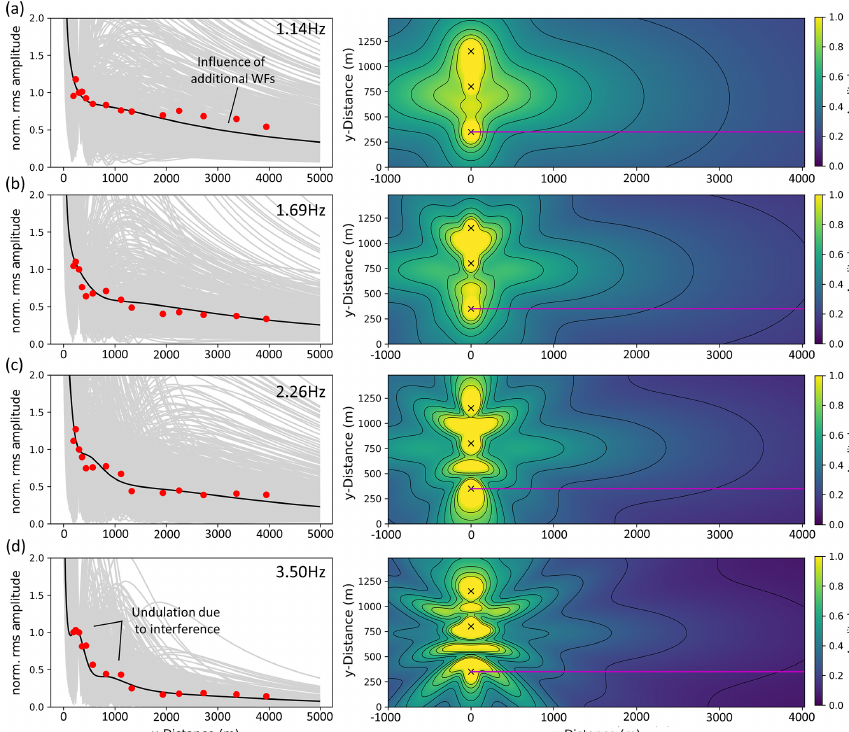
Figure 12. Averaged modeled radiation patterns (right) and averaged amplitude decays (left, black line) along the profile (magenta line) by averaging 500 wave fields and decay curves (gray lines), based on random φ (between 0 ,π ) to eliminate the effect of phase differences between source signals. Red dots represent the observed amplitudes in Uettingen at (a) 1.14Hz, (b) 1.69Hz, (c) 2.26Hz, and (d) 3.50Hz.